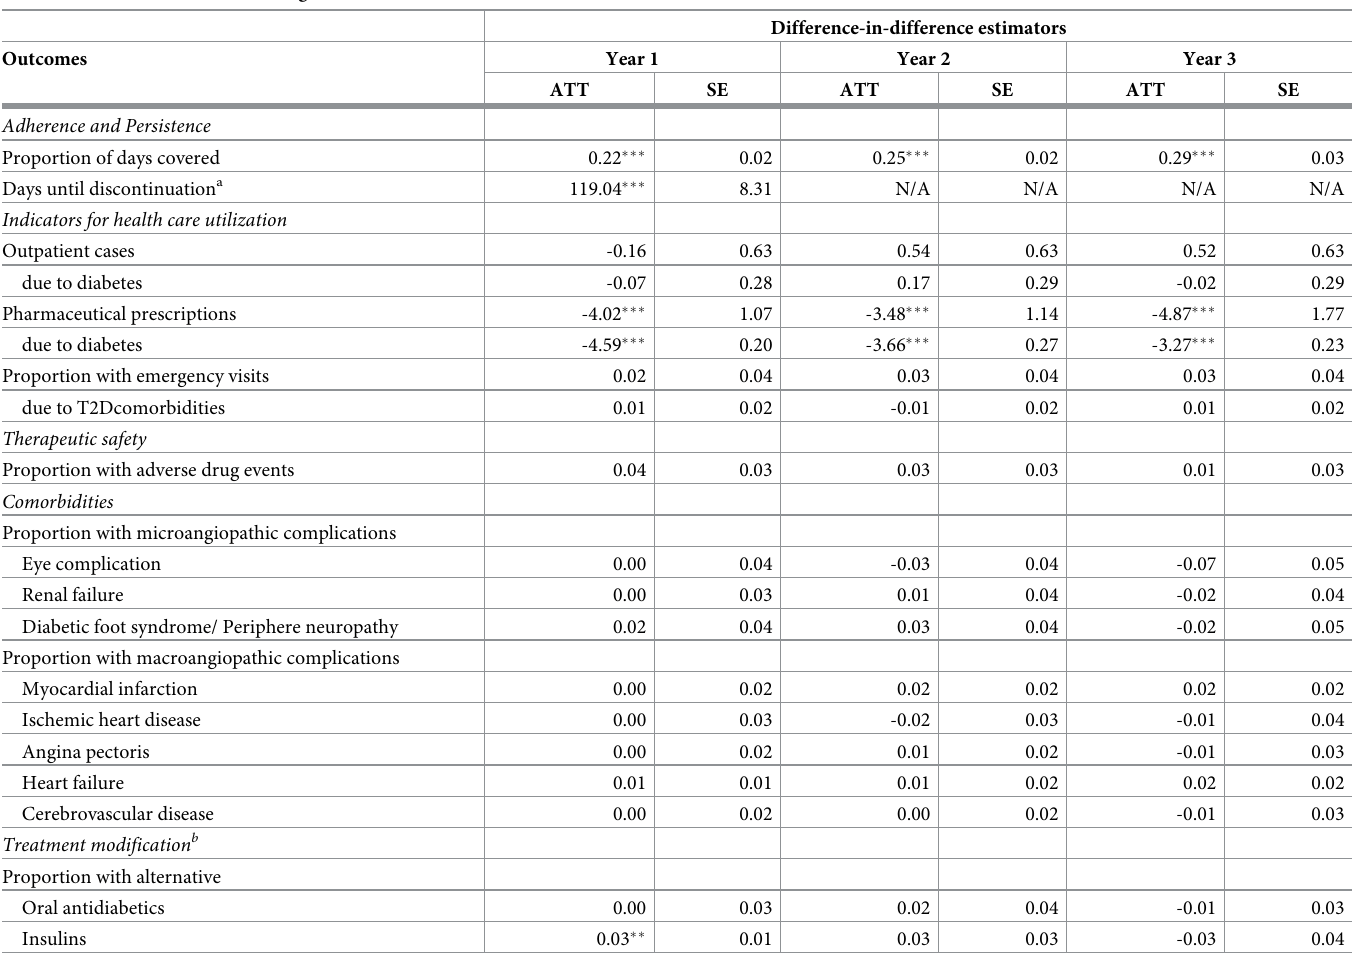
Table 2. Difference-in-difference regression